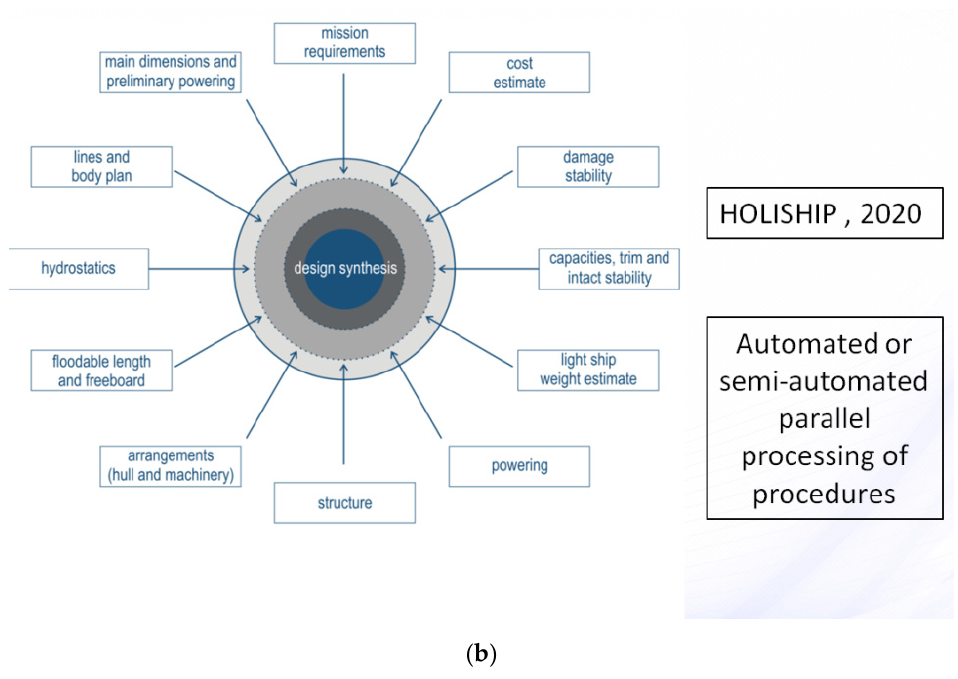
Figure 6. ( a ) Design Spiral/Serial Processing [13]. ( b ) Design Synthesis/Parallel Processing [16].